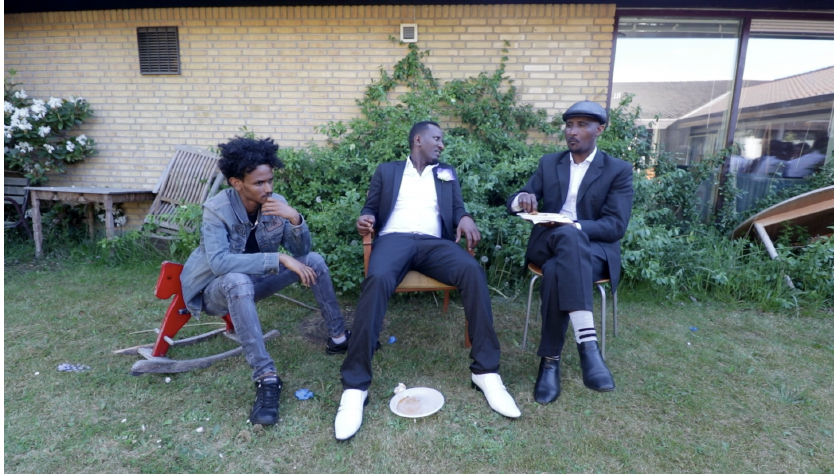
Figure 10. Wedding. Guests sitting in the garden. May 2017.